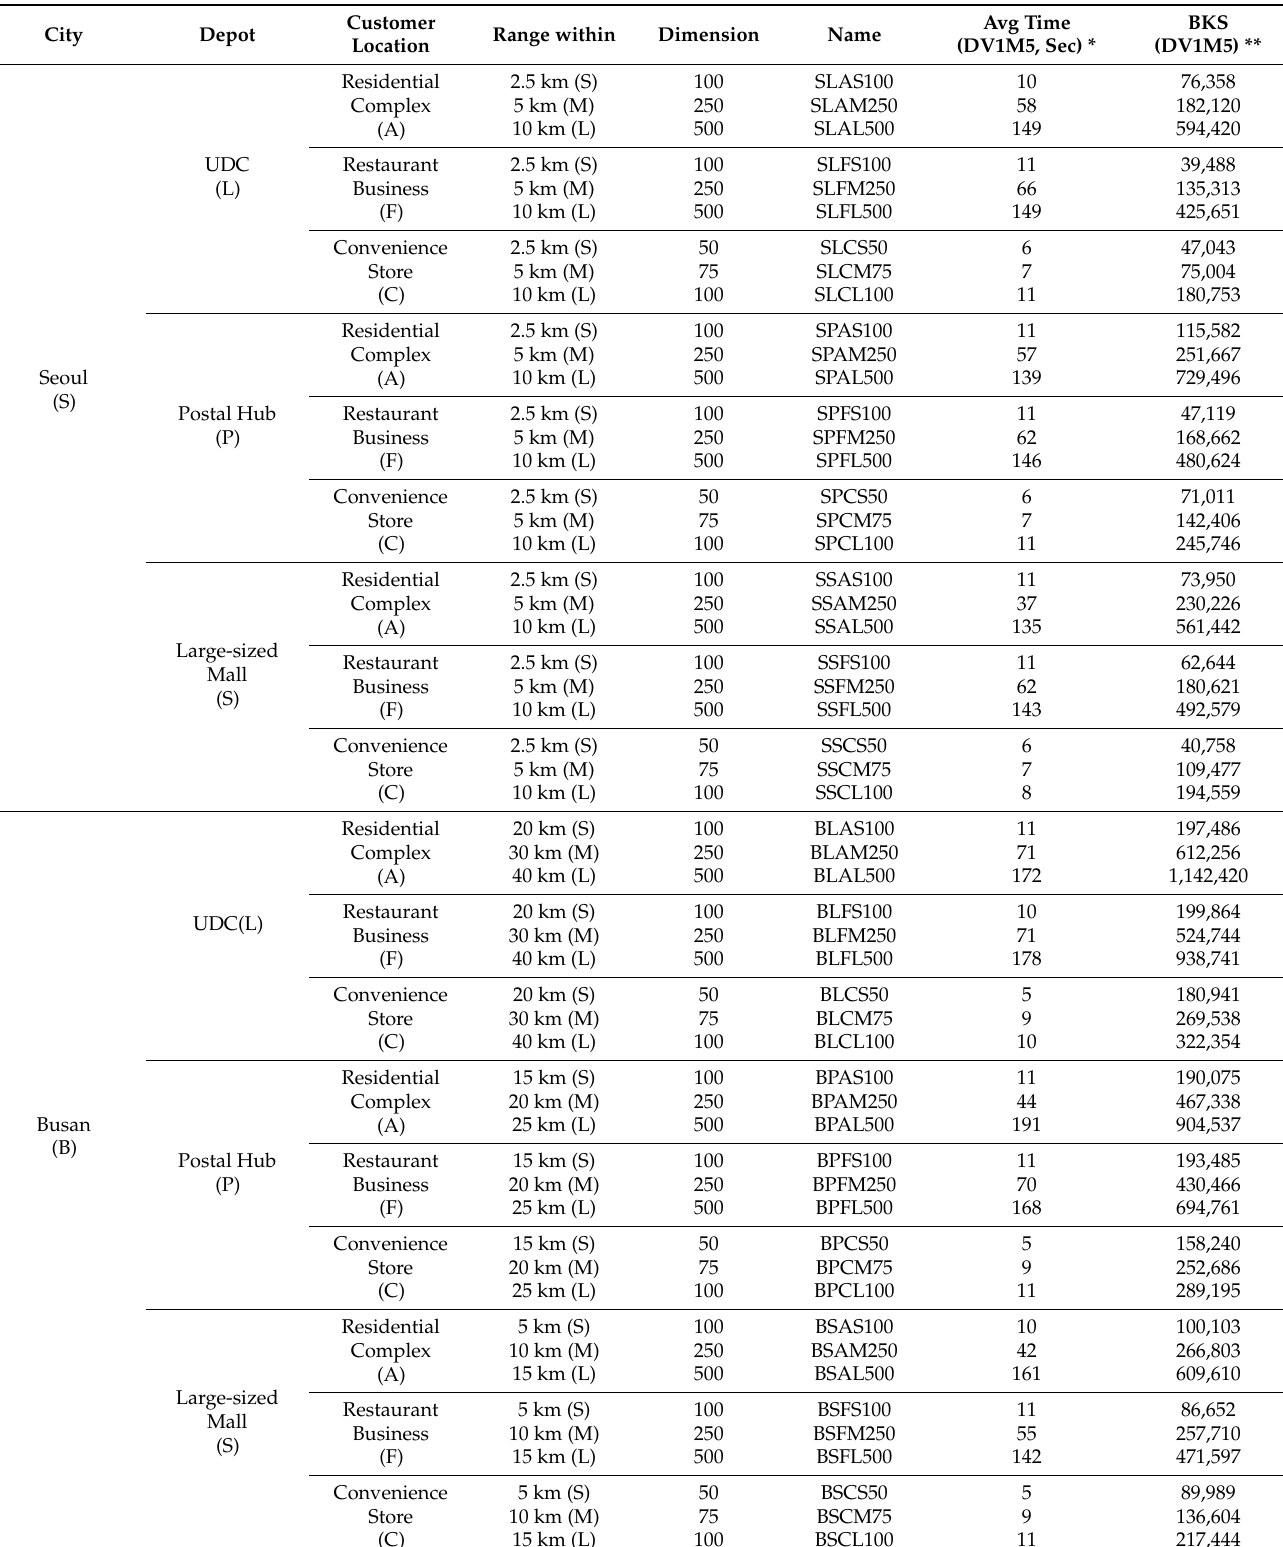
Table 2. Enumerative list of proposed benchmark